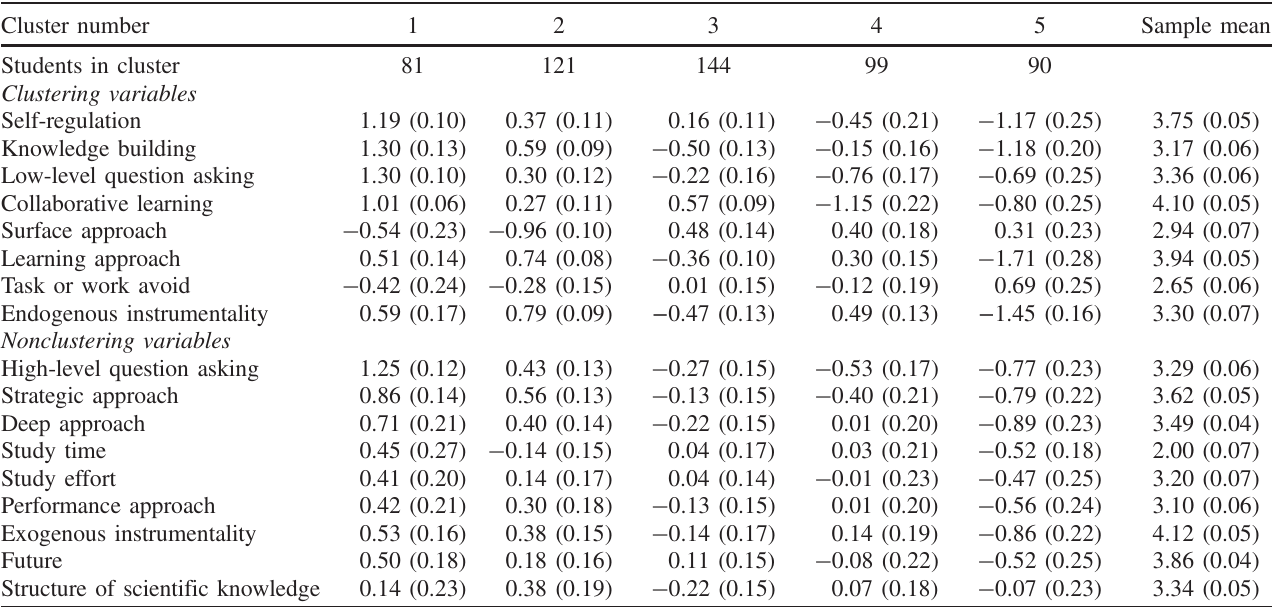
TABLE III. Standardized cluster means (and the half-width of their 95% confidence intervals) for the five-cluster solution. The overall sample means used to standardize data for each sale (and the half-width of their 95% confidence intervals) are given in the right column for